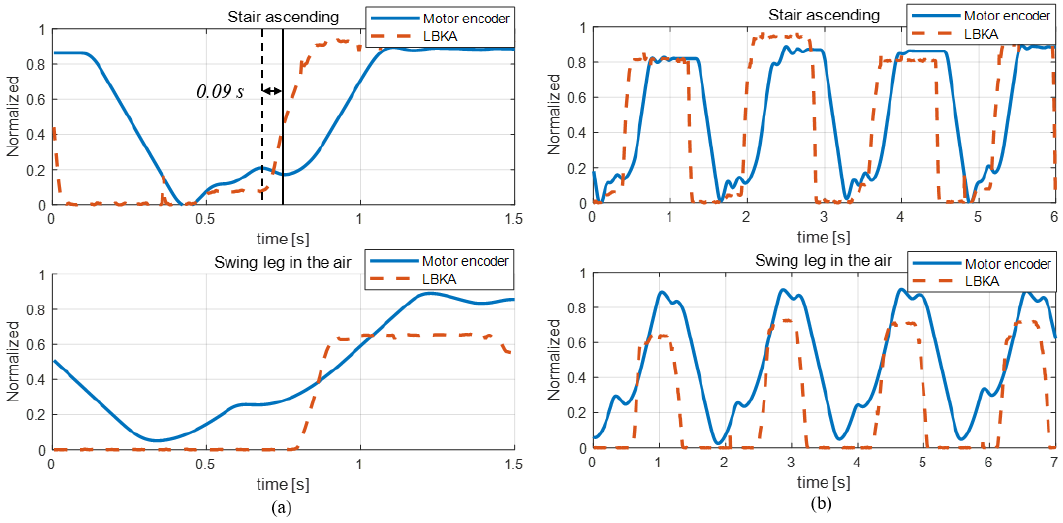
Figure 9. Graph of the actual ascending stair, and when the leg is swung in the air like the process of an ascending stair: ( a ) detailed motion view of each motion, ( b ) continuous motion data.